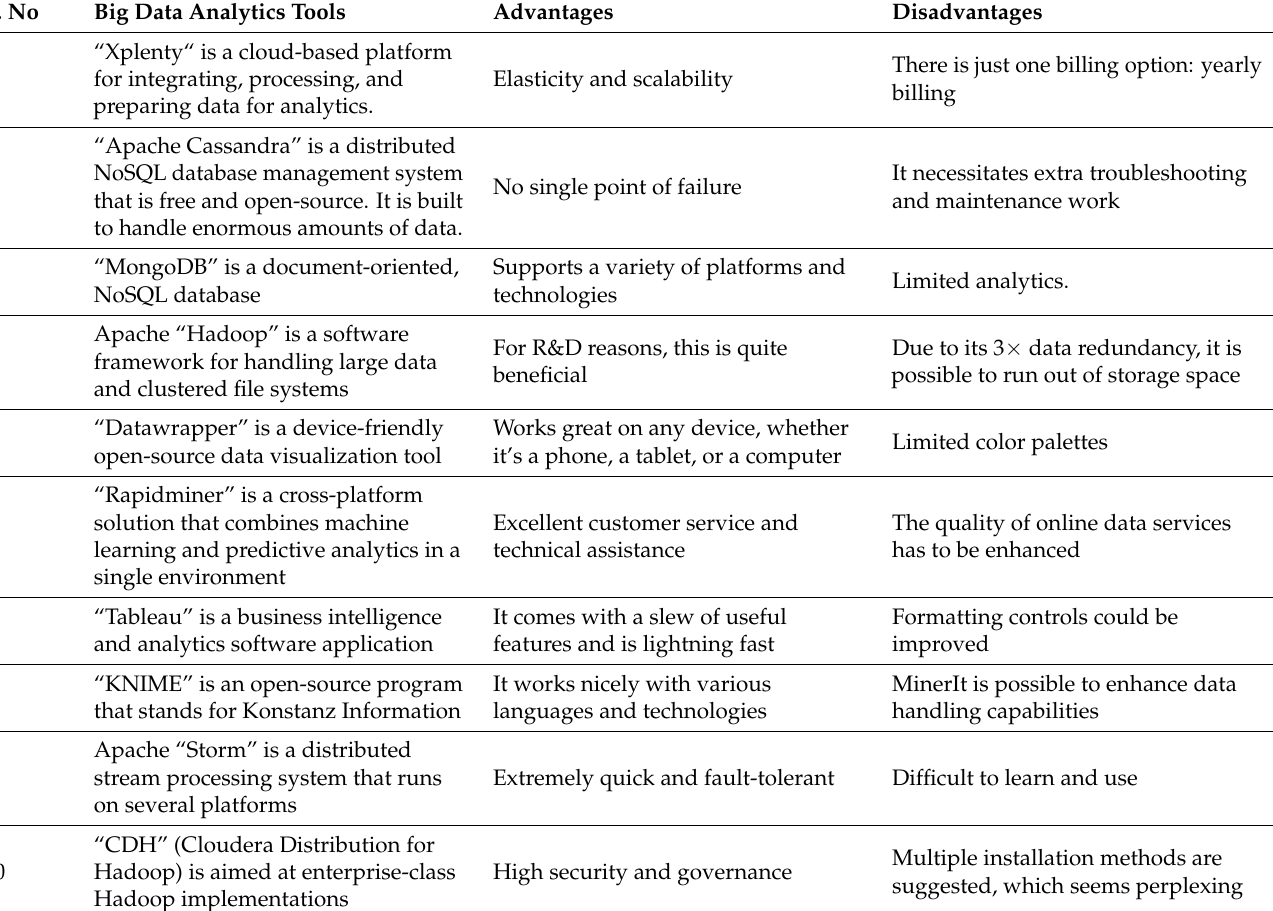
Table 2. Listing of available big data tools with their advantages and